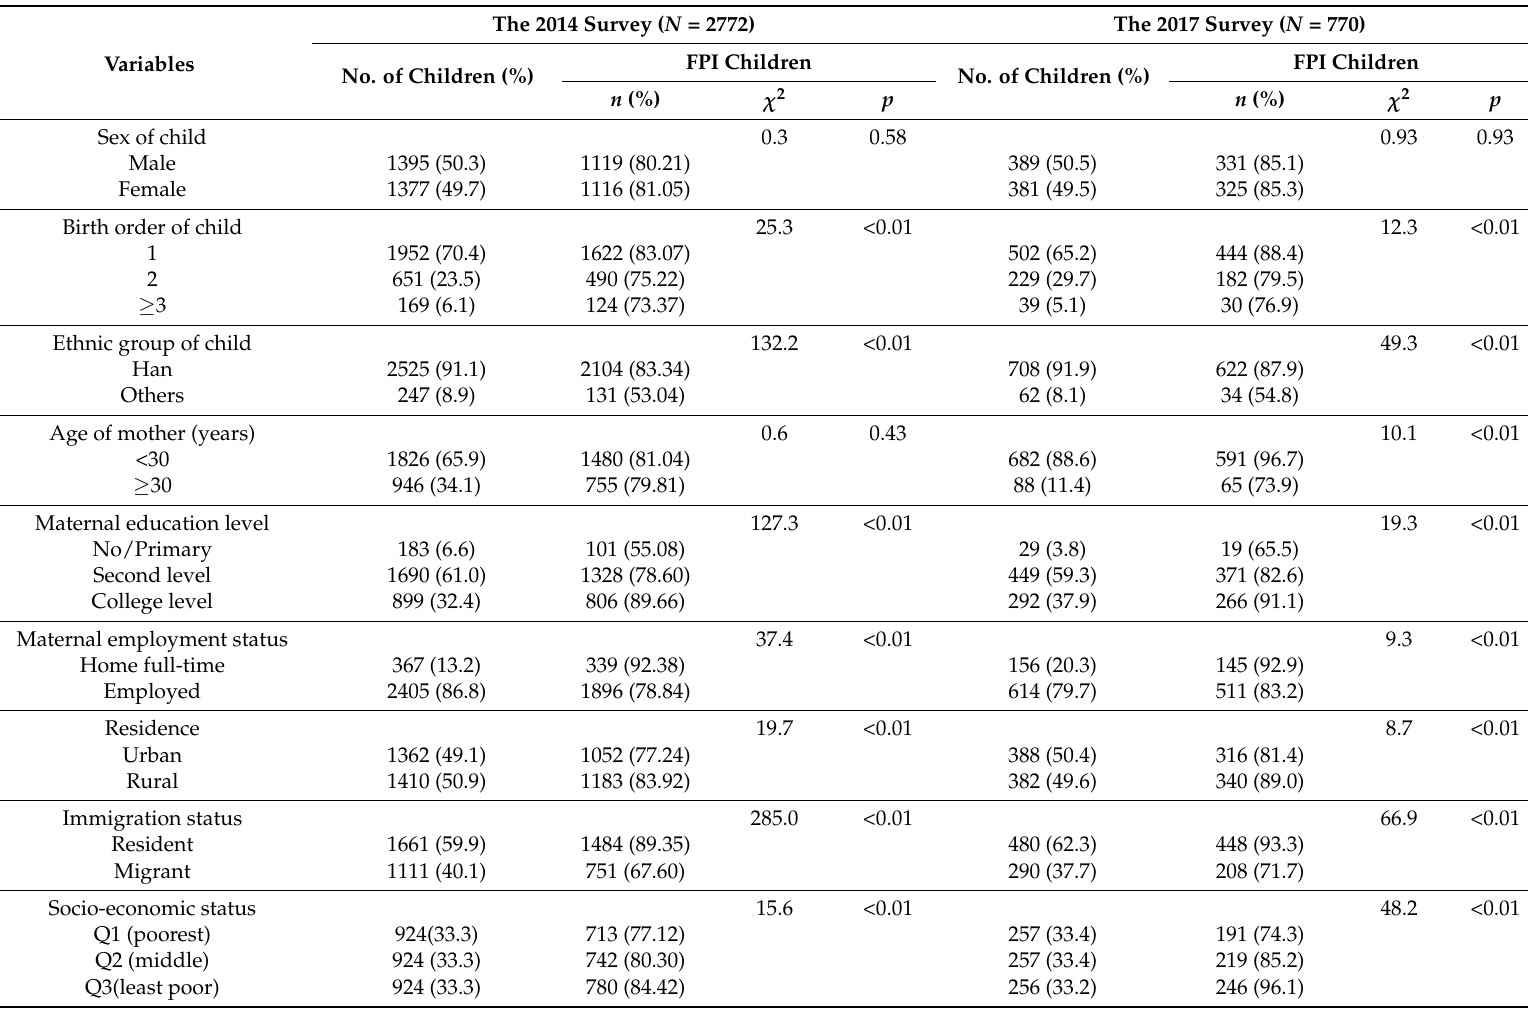
Table 1. Demographic and socioeconomic characteristics and the coverage of full primary immunization (FPI) of children aged 24–35 months in the 2014 and 2017 coverage